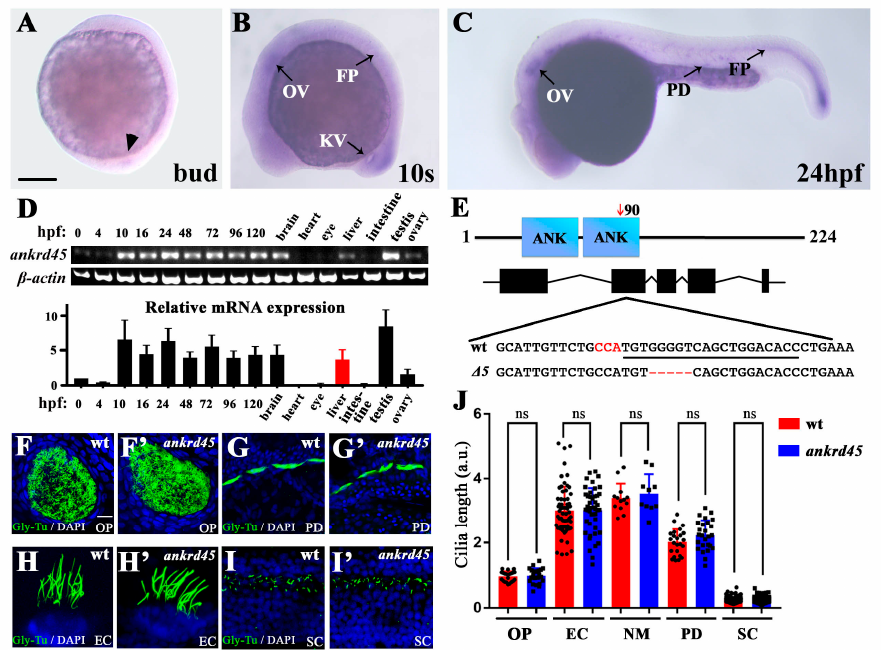
Figure 1. Expression pattern of ankrd45 and cilia development in ankrd45 mutants. ( A–C ) Whole-mount in situ hybridization results showing the expression of ankrd45 at different stages. ( A ) At the bud stage, ankrd45 is expressed in the dorsal forerunner cells (arrowhead). ( B ) At the 10-somite stage, ankrd45 is expressed in the otic vesicle (OV), Kupffer’s vesicle (KV), and floor plate (FP). ( C ) ankrd45 is enriched in the otic vesicle, the pronephric duct (PD), and the floor plate at 24 hpf. ( D ) Real-time PCR showing the expression of ankrd45 at different stages or adult tissues as indicated. Bottom: bar graph showing the relative expression levels of ankrd45 at different stages or adult tissues as indicated. ( E ) Diagram showing the genomic structure of the zebrafish ankrd45 gene. Bottom shows the sequences of wild-type and mutant alleles ( Δ 5 ). Underlined sequence indicates the spCas9 target region, and the PAM sequence is indicated in red. ( F–I’ ) Confocal images showing the cilia in the olfactory pit ( F,F’ ), pronephric duct ( G,G’ ), ear cristae ( H,H’ ), and spinal cord ( I,I’ ) in wild-type or mutant larvae visualized with anti-glycylated tubulin antibody. ( J ) Bar graph showing the length of cilia per arbitrary unit (a.u.) in different organs as indicated. OP, olfactory pit; EC, ear cristae; SC, spinal cord; NM, neuromast. Scale bars: 200 μ m in A-C; 20 μ m in F-I’. ns, not significant.